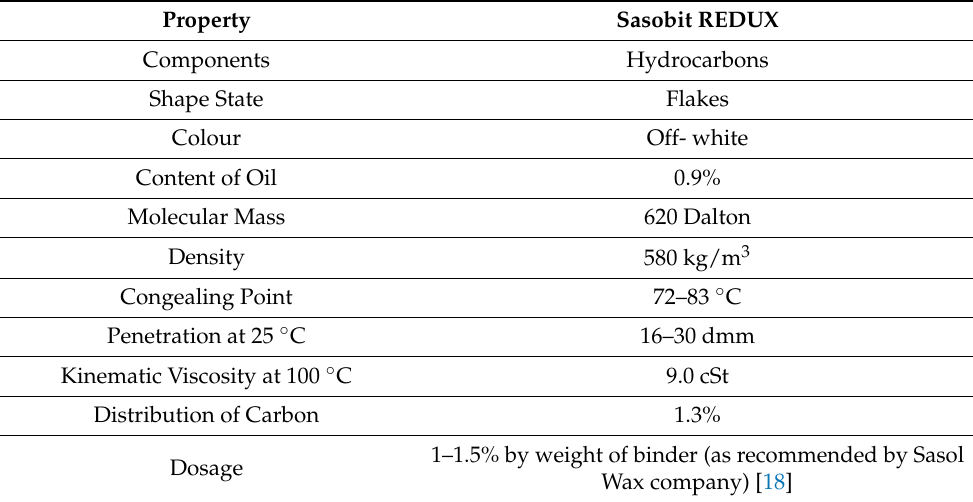
Figure 3. Flakes of Sasobit REDUX. Table 5. The physical properties of Sasobit REDUX.